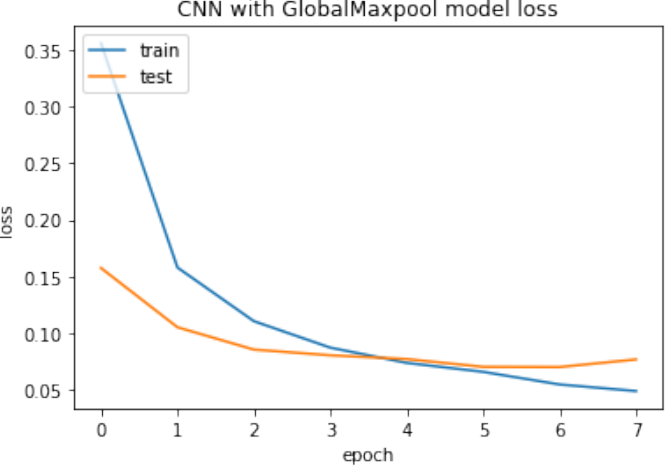
Figure 23. CNN with GlobalMaxpool model